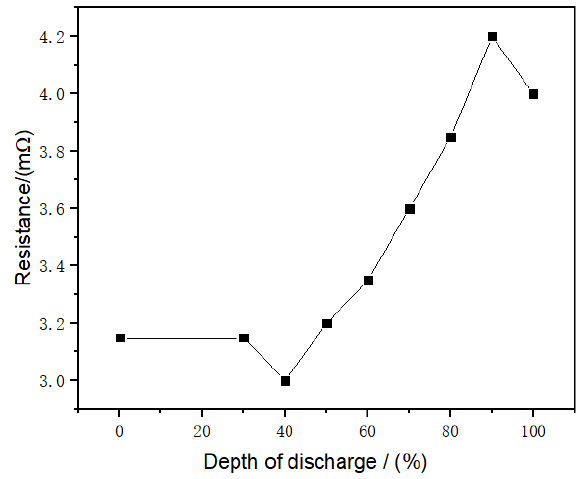
Figure 10. Relationship between battery internal resistance and depth of discharge [35].